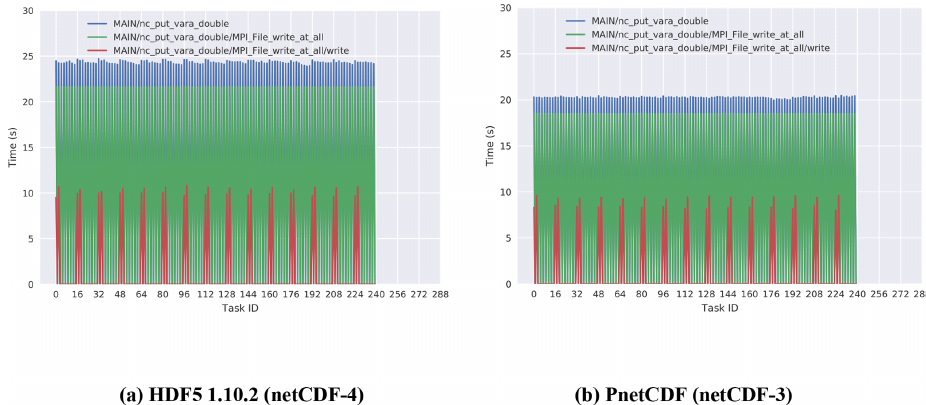
Figure 13. Time distribution over PEs of major write call path functions, i.e. nc_put_vara_double for netCDF, MPI_File_write_at_all for MPI-IO and POSIX call write. The benchmark is running on 240 ranks with an I / O layout of 8 × 15.